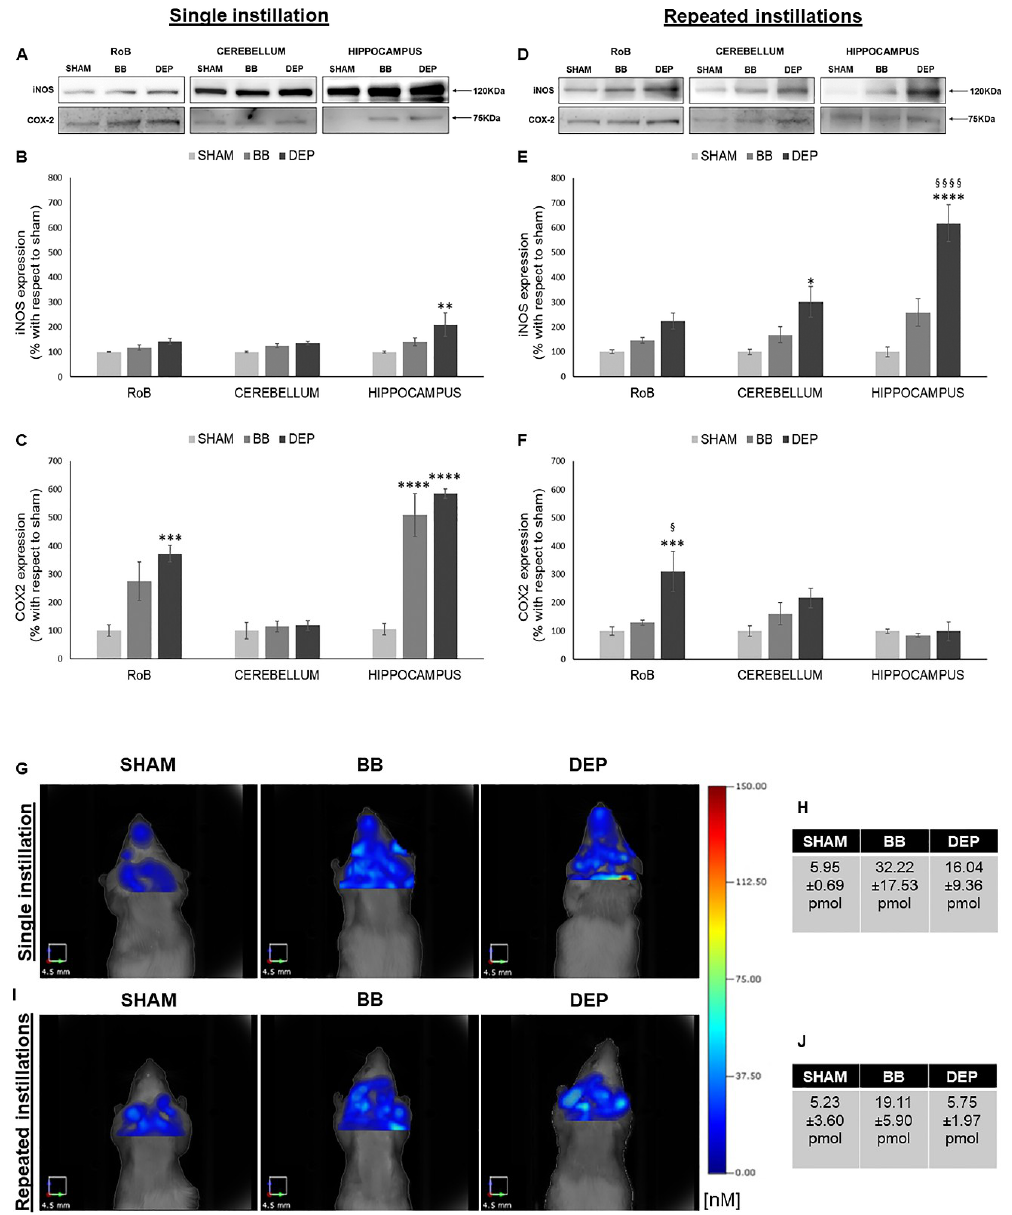
Figure 2. Inflammation analysis after single and repeated instillations of BB and DEP. ( A – F ) Representative immunoblotting images of inducible nitric oxide synthase (iNOS) and cyclooxygenase 2 (COX-2) analysis in mice after single ( A ) and repeated ( D ) instillations with 50 μg of BB or DEP/100 μL 0.9% NaCl. Histograms display iNOS and COX-2 expression in mice after single ( B , C ) and repeated ( E , F ) instillations with BB and DEP, with respect to sham. Proteins are normalized to corresponding total proteins revealed by Ponceau in each lane (Figure S3, Supplementary Materials), and the data are expressed as means ± SEM ( n = 6). Statistical differences were tested accordingly by one-way ANOVA followed by Tukey post hoc comparison. * p < 0.05 vs. sham mice; ** p < 0.01 vs. sham mice; *** p < 0.001 vs. sham mice; **** p < 0.0001 vs. sham mice; § p < 0.05 vs. BB-treated mice; §§§§ p < 0.0001 vs. BB-treated mice. ( G – J ) Representative fluorescence molecular tomography (FMT) images of sham, as well as BB- and DEP-treated, mouse brain obtained 24 h after single ( G ) and repeated ( I ) intratracheal instillations with 50 µ g of BB or DEP / 100 µ L 0.9% NaCl. Each figure represents the results obtained from two mice for every treatment, and tables report the quantification of MMPsenseTM 750 FAST probe (pmol) after single ( H ) and repeated ( J ) intratracheal instillations. Data are expressed as means ± standard